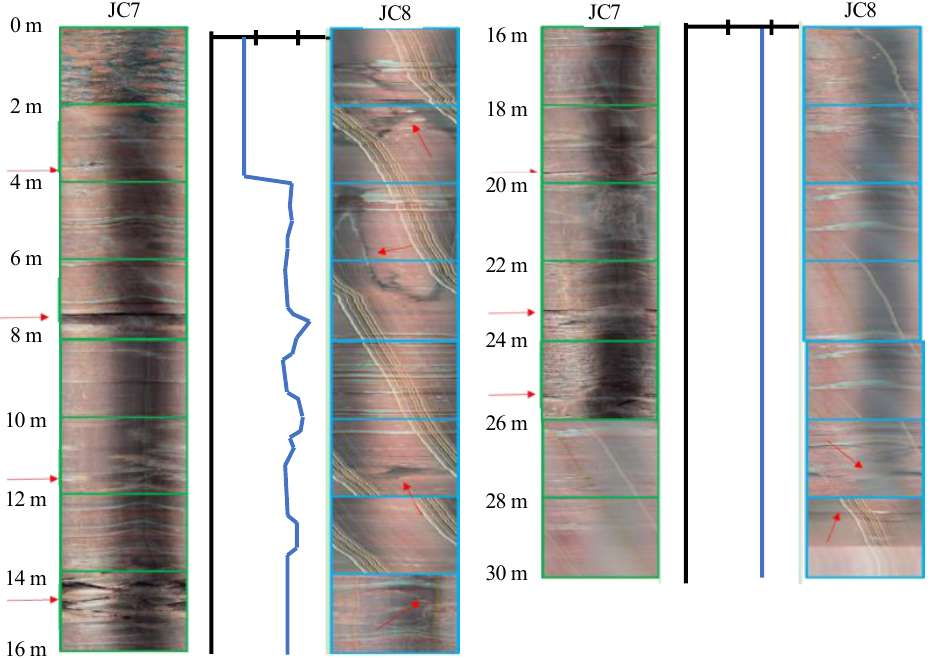
Figure 19. Comparison of borehole images and acoustic velocity measurement (175 m). The curves of the changes in the cross-borehole acoustic wave velocity with depths at 146 m, 161 m, and 175 m were obtained (Figure 20). Notably, the ZK is the abbreviation of the specific boreholes for the test of cross-hole acoustic wave velocity, and JC is the abbreviation of the specific boreholes for the inclinometer monitoring. Figure 20a shows that in the depth intervals 8.8 – 10.6 m and 15 – 21 m, the effective cross-hole acoustic wave values were 5.09 km/s and 4.03 km/s, respectively. Because most of the rock masses were relatively broken, the wave values in the other depth intervals were invalid. Correspond- ingly, the effective values of the cross-borehole acoustic wave velocity at depths of 12.8 – 13.6 m and 17.6 – 19 m in ZK03/04 were 2.49 km/s and 4.50 km/s, respectively (Figure 20b). The effective value of the cross-borehole acoustic wave velocity was obtained in ZK07/08 at depths of 7 – 13.6 m was 4.42 km/s (Figure 20c).